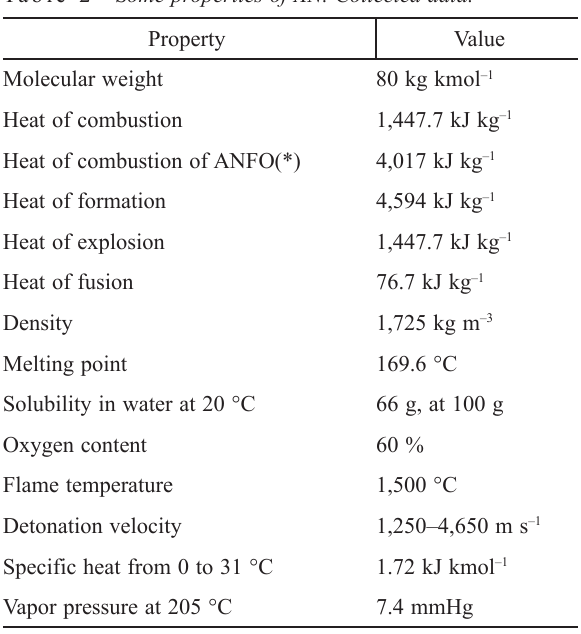
Table 2 – Some properties of AN. Collected data.